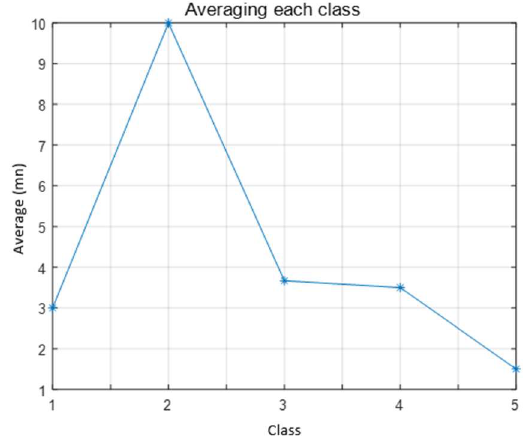
Figure 7. Representation of the average of each class.